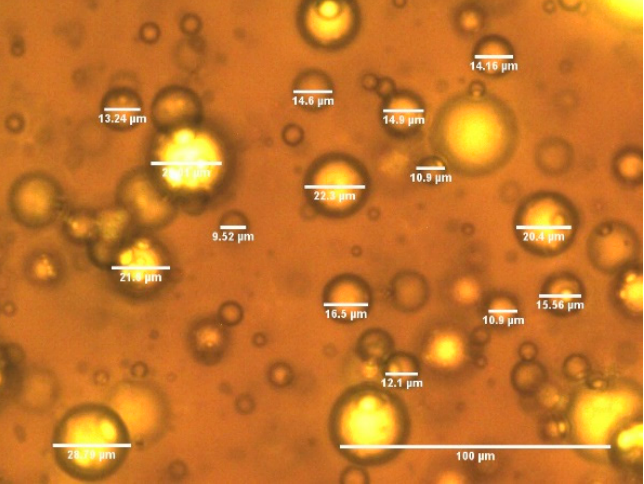
Figure 22. Sample P with 15% ( v / v ) water added. Dg average = 14 µm ± 0.01 .